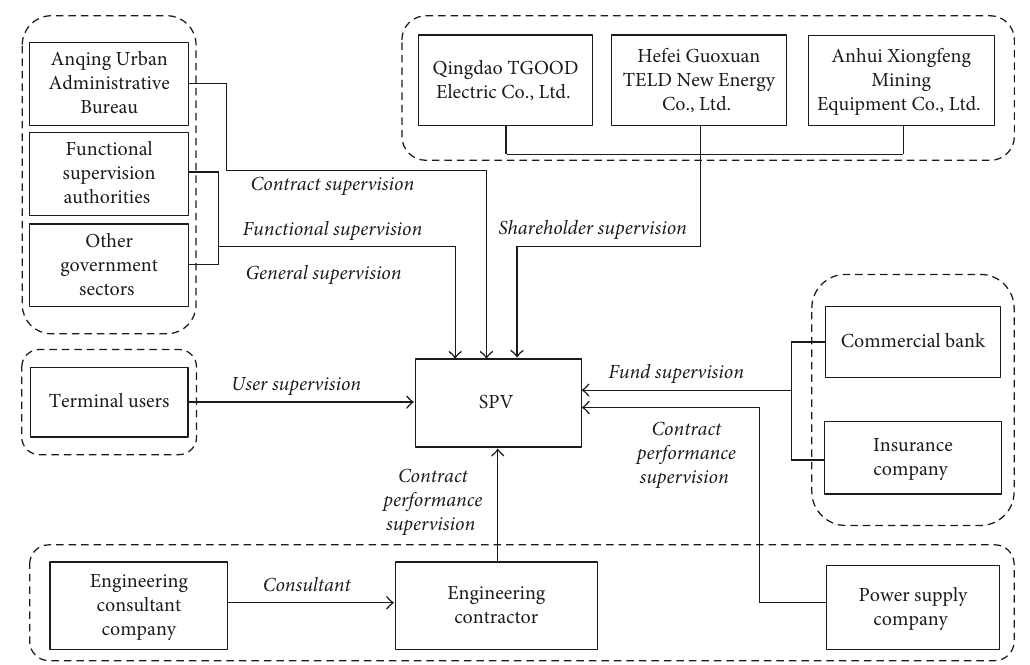
Figure 3: Supervision framework of the Anqing